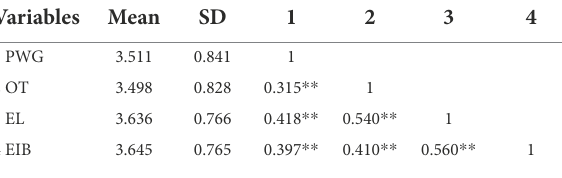
TABLE 3 Descriptive statistics and correlations among variables. TABLE 4 Results on the mediating role of employee loyalty with PWG and employee innovative behavior.